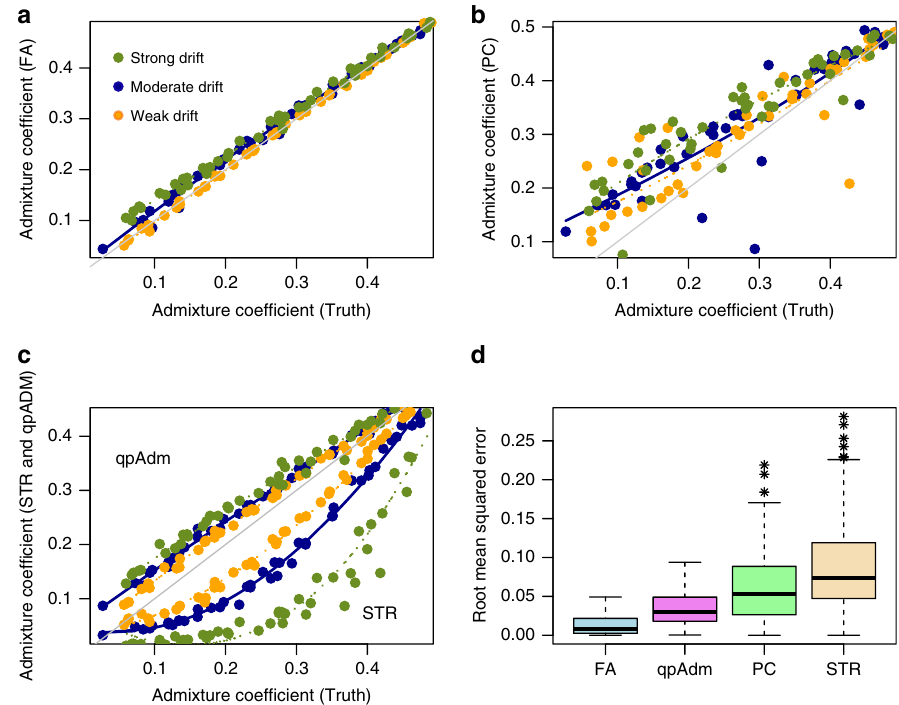
Fig. 2 Comparisons of ancestry estimates. Inference of ancestry proportions in two-way admixture models with high level of divergence between the ancestral populations ( F ST = 25%). a Ancestry estimates obtained from FA for three levels of drift intensity represented in green, blue and orange colors, b Ancestry estimates obtained from PC projections on admixed samples, c Ancestry estimates from qpAdm (above diagonal) and STRUCTURE (STR, below diagonal), d Root mean squared errors for admixture estimates from the four methods. FA: Factor Analysis, PC: Projections on PCs of admixed samples, STR: STRUCTURE estimates computed with non-negative matrix factorization. Boxplots computed on m = 135 replicates (minimum, median, interquartile range, 1.5 IQR away from 75th percentile or maximum). Gray line: diagonal, colored line: local regression.